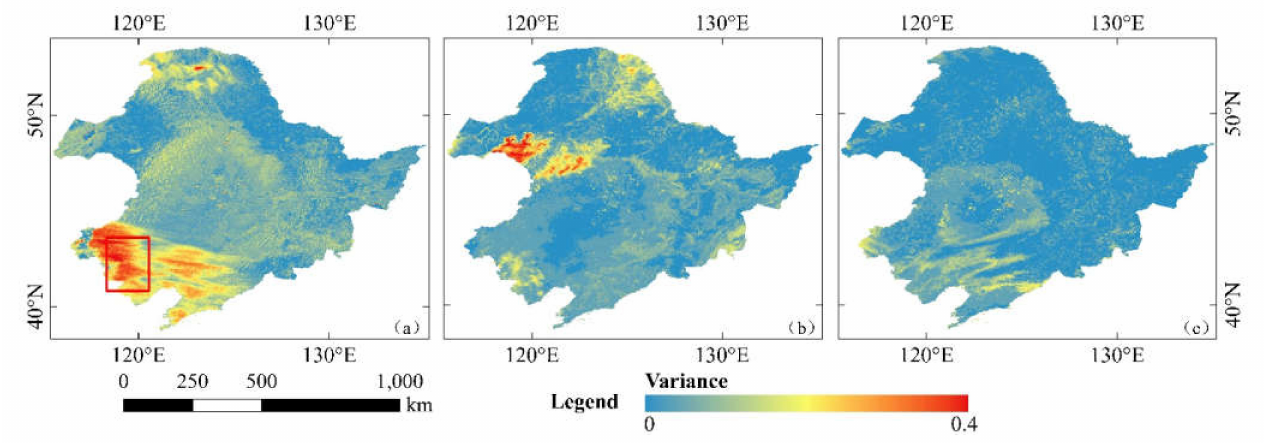
Figure 10. NDSI_var images ( a ) 12 February 2019, ( b ) 22 March 2018, and ( c ) 16 March 2018.